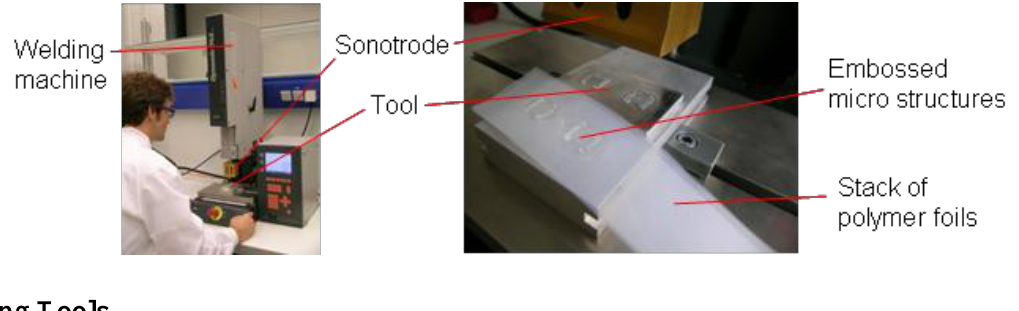
Figure 3. Left: 35 kHz ultrasonic welding machine; Right: Sonotrode, polymer foils, and tool.